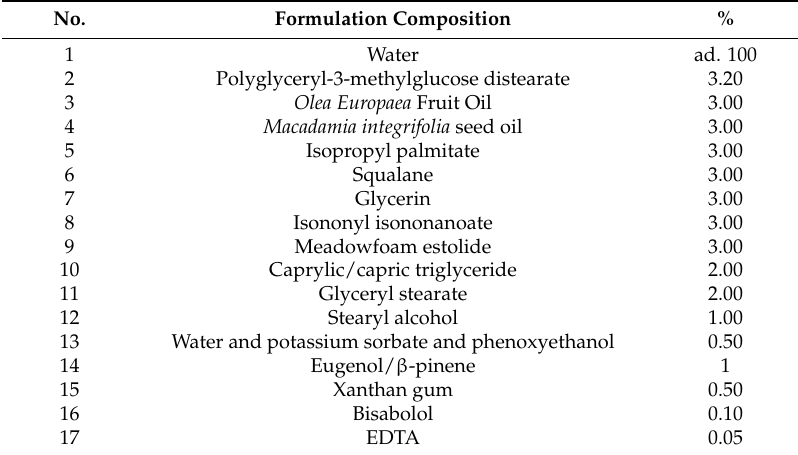
Table 6. Formulation